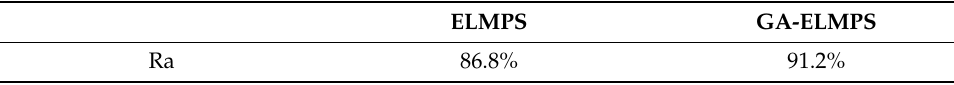
Table 9. Prediction accuracies of ELMPS and